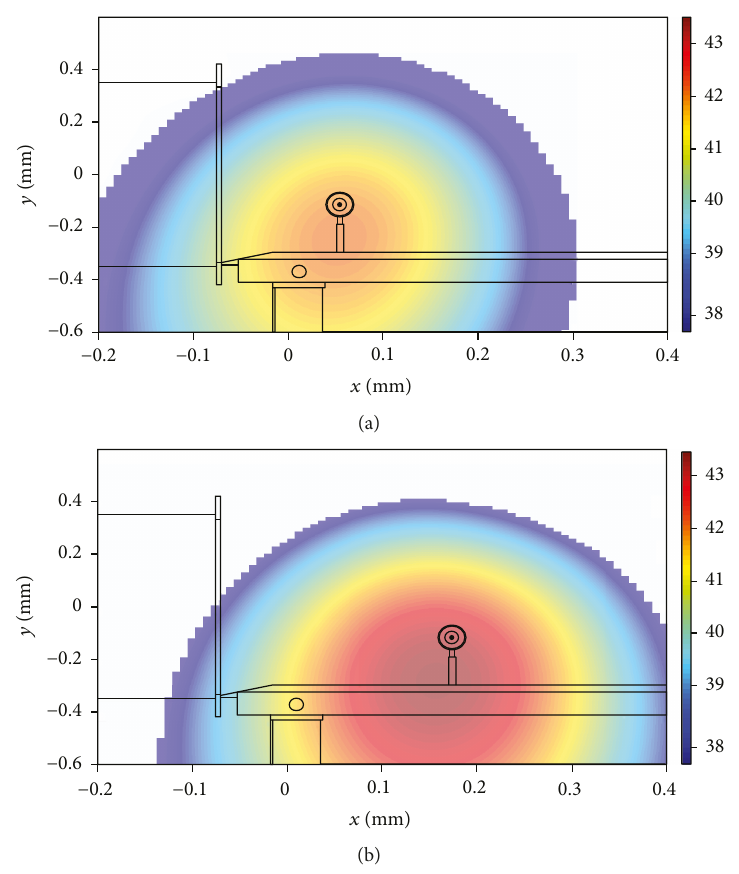
Figure 14: Beamforming results at 900Hz: (a) Case 7; (b) Case